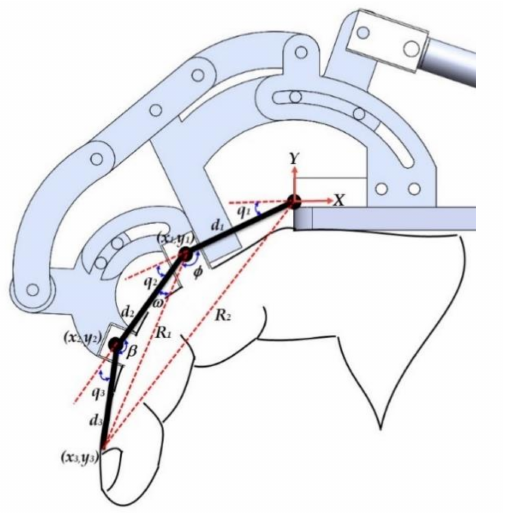
Figure 4. Inverse kinematics